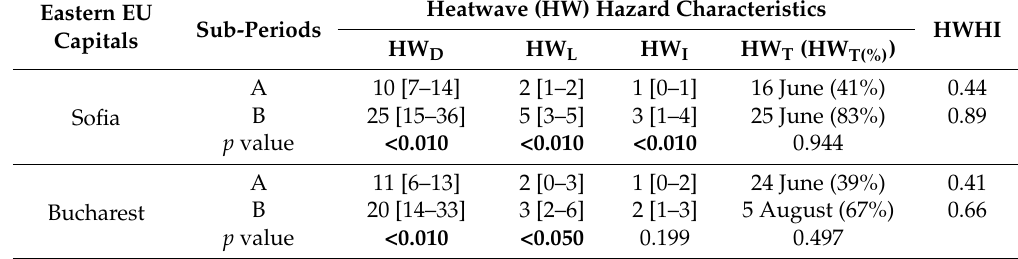
Table 8. The median of heatwave (HW) hazard characteristics (HW D : HW days; HW L : long HWs; HW I : high-intensity HWs; HW T : the timing of the first simultaneously long and high-intensity HW) and the value of the Heatwave Hazard Index (HWHI) referred to the 1980–1997 (A) and the 1998–2015 (B) 18-year sub-periods for southern EU capitals. The 75th and 25th percentiles of HW D , HW L and HW I (in square brackets) and the frequency of years with at least one simultaneously long and high-intensity HW (HW T(%) in round brackets) are shown. The significance level ( p value) of associations between the two 18-year sub-periods are shown (bold when